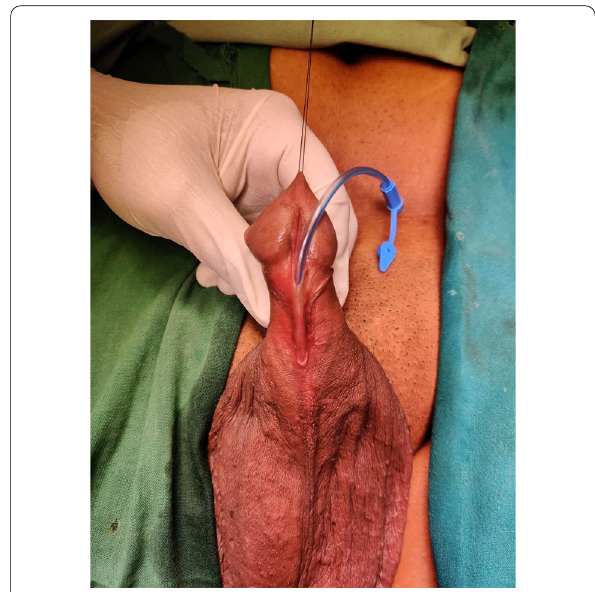
Fig. 3 A 14 years old with primary hypospadias with narrow urethral plate and diverging corpora spongiosum with a Glans score of 3 (excluded from the study)